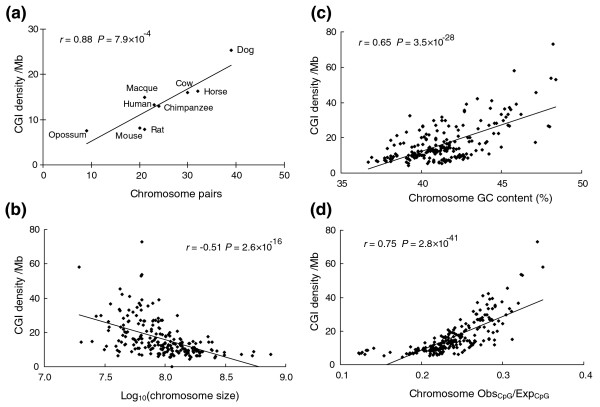
Correlations between CGI density and genomic features in nine mammalian genomes. The platypus chromosomes were excluded because of incomplete genome sequence data and chromosome data. (a) CGI density (per Mb) versus number of chromosome pairs. (b) CGI density (per Mb) versus log10(chromosome size). The Y chromosomes were excluded because of insufficient data. (c) CGI density (per Mb) versus chromosome GC content (%). (d) CGI density (per Mb) versus chromosome ObsCpG/ExpCpG.